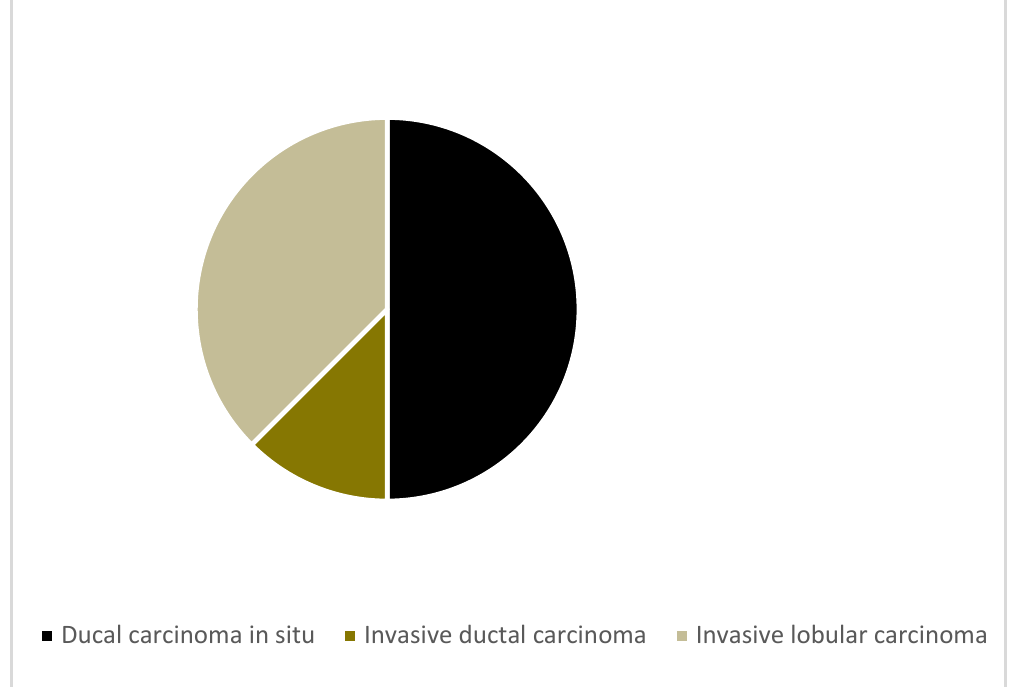
Figure 2. Malignant histological subtypes.